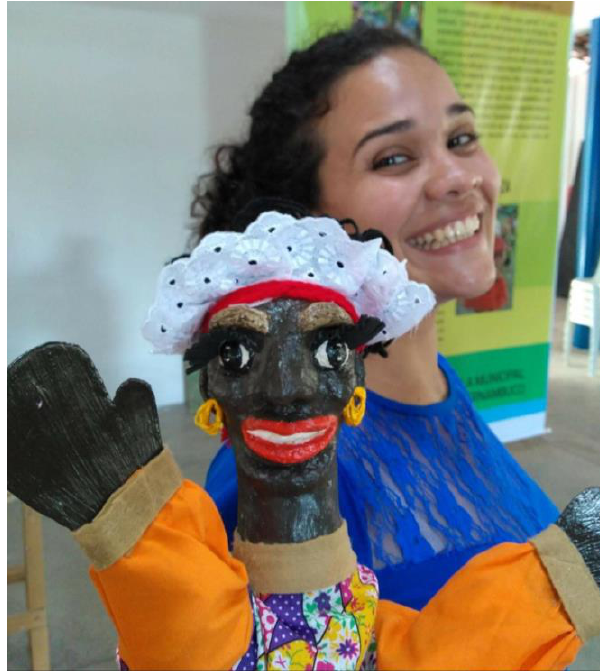
Figure 7. Dandara paper-mache puppet by Denyse Gonzalez.